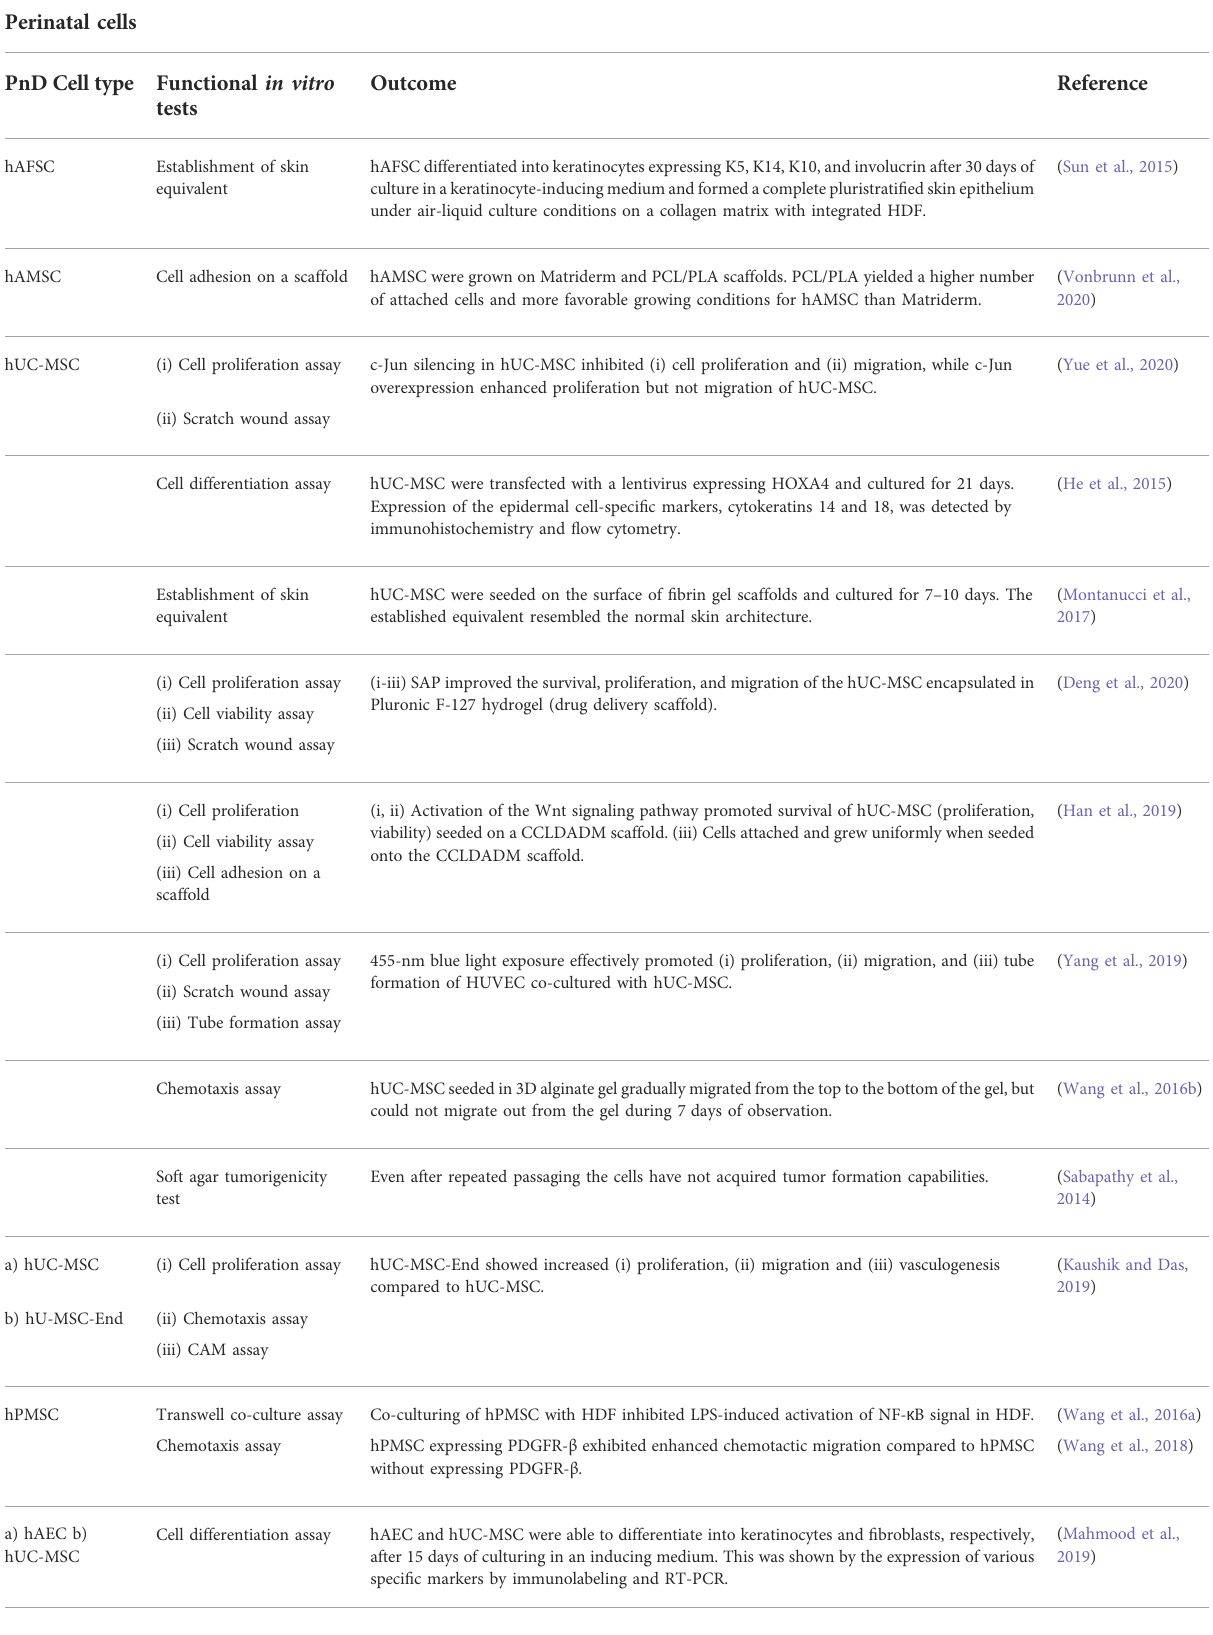
TABLE 1 Functional tests on perinatal